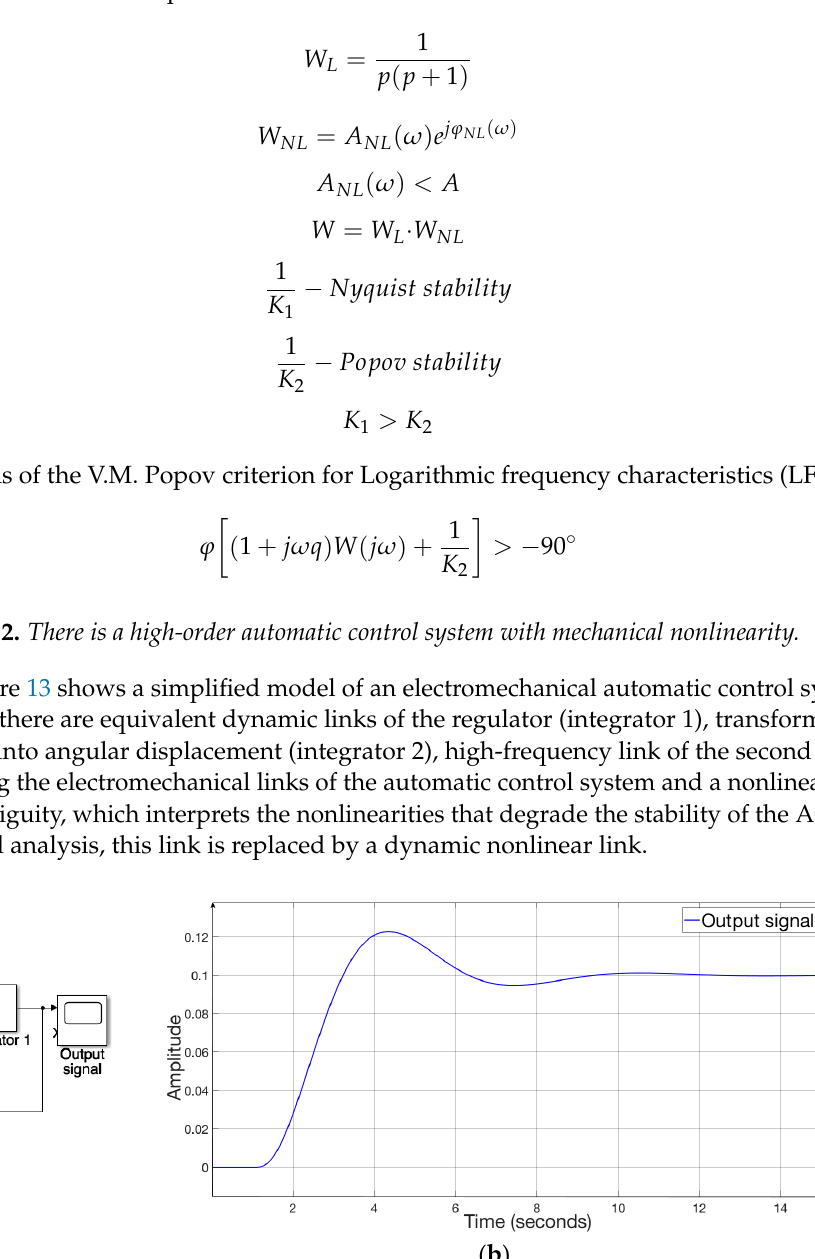
Figure 14. Scheme of an unstable nonlinear ACS and processes at different gain factors K1,2. Expressions (16)–(19) illustrate the simulation results in the mathematical form. Herein 𝑊 (cid:3013)(cid:2869) is a transfer function of linear link, 𝑊 (cid:3015)(cid:3013) is a transfer function of nonlinear link in the exponential form, 𝜑(𝜔) is a phase, and 𝐴(𝜔) is an amplitude. 𝑊 (cid:3013)(cid:2869) = 1 𝑝 (cid:2870) ∙